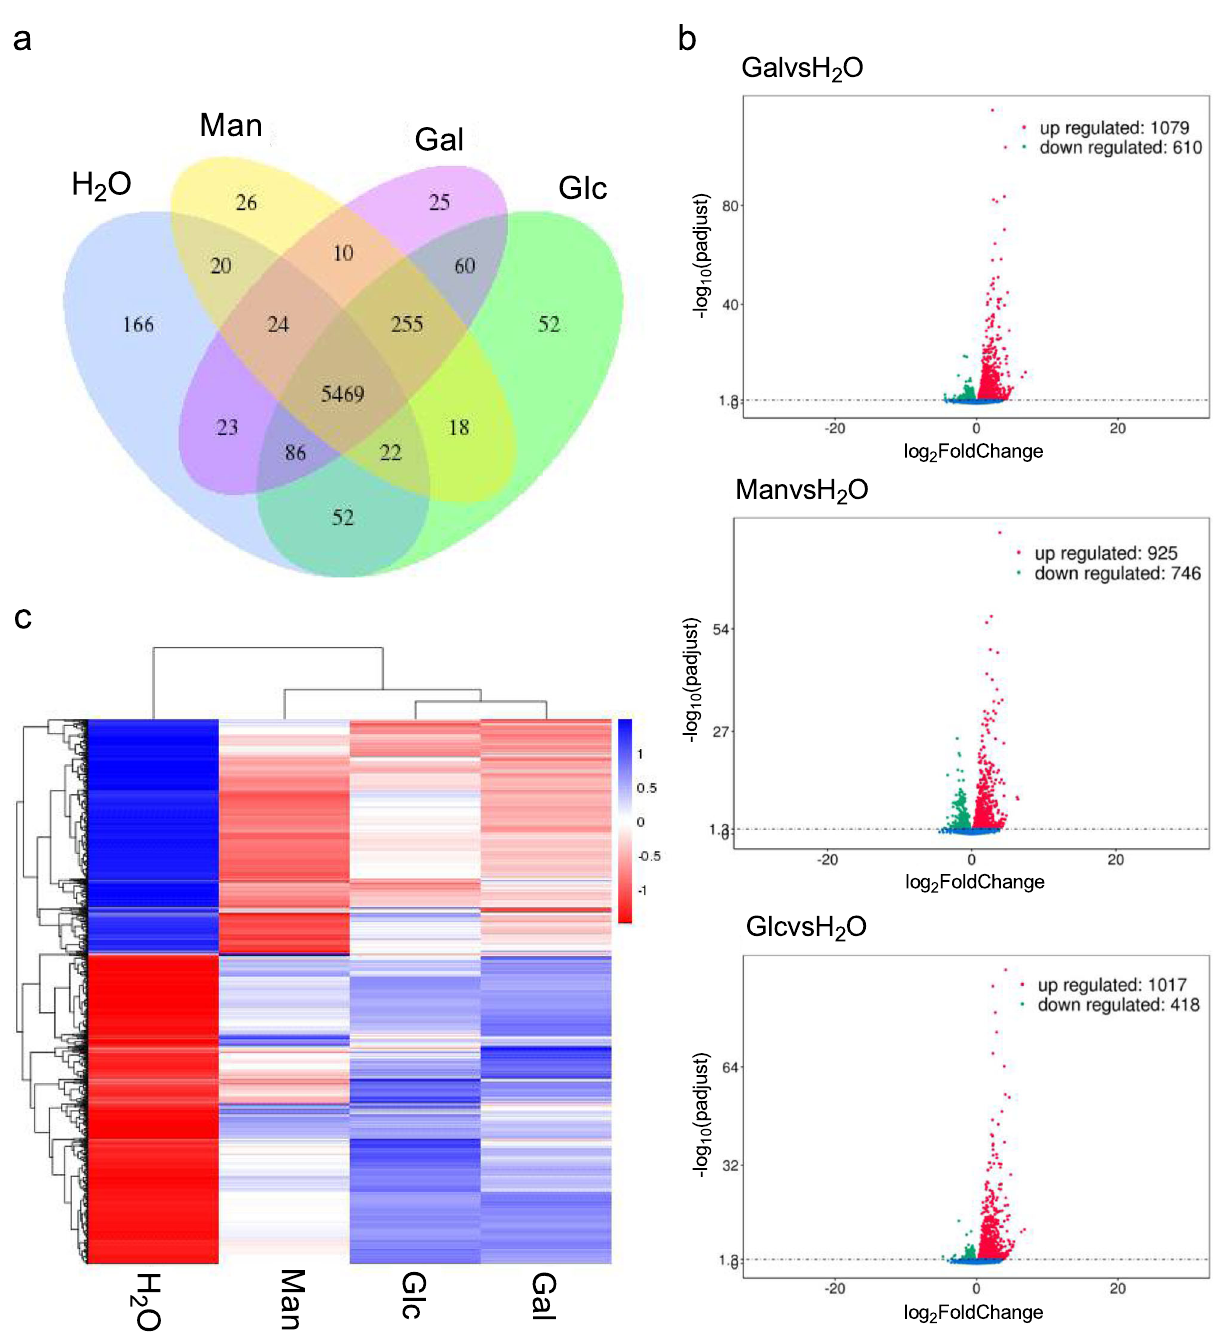
Fig. 2 Gene expression in B. salamandrivorans . a Co-expression Venn diagram presents the number of genes that are uniquely expressed within each group per sample, with the overlapping regions showing the number of genes that are co-expressed in two or more groups per samples. b Volcano plots of differentially expressed genes identi fi ed between the galactose, glucose, or mannose group and control group. The green dots denote downregulated gene expression, the red dots denote up-regulated gene expression, and the blue dots denote the gene expression without marked differences. c FPKM cluster analysis, clustered using the log 10 (FPKM + 1) value. Blue denotes genes with high expression levels, and red denotes genes with low expression levels. The colour ranging from blue to red indicates log 10 (FPKM + 1) value from large to small. Trees indicate hierarchical clustering between data sets (above) and genes (left of heatmap). Gal = galactose; Glc = glucose; Man = mannose. Source data are provided as a Source Data fi